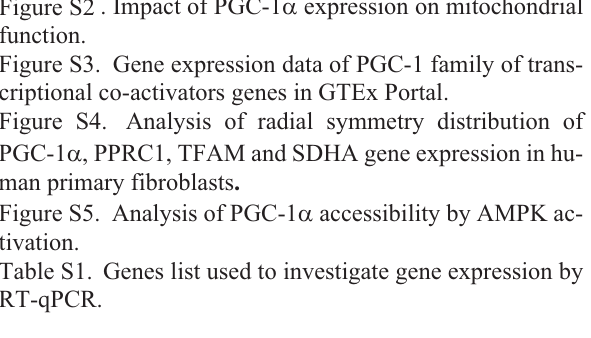
Figure S2 . Impact of PGC-1 (cid:2) expression on mitochondrial function. Figure S3. Gene expression data of PGC-1 family of trans- criptional co-activators genes in GTEx Portal. Figure S4. Analysis of radial symmetry distribution of PGC-1 (cid:2) , PPRC1, TFAM and SDHA gene expression in hu- man primary fibroblasts . Figure S5. Analysis of PGC-1 (cid:2) accessibility by AMPK ac- tivation. Table S1. Genes list used to investigate gene expression by